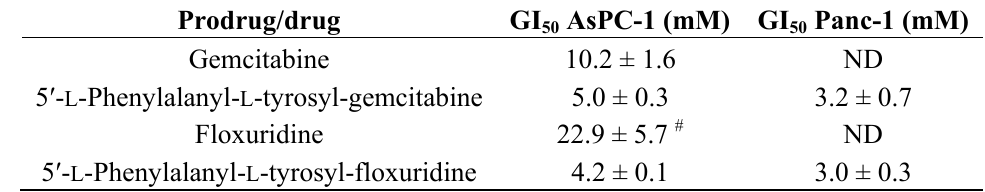
Table 5. Cell Growth Inhibition in AsPC-1 and Panc-1 Cells by floxuridine, floxuridine prodrug, gemcitabine, and gemcitabine prodrug (mean ± SD, n =